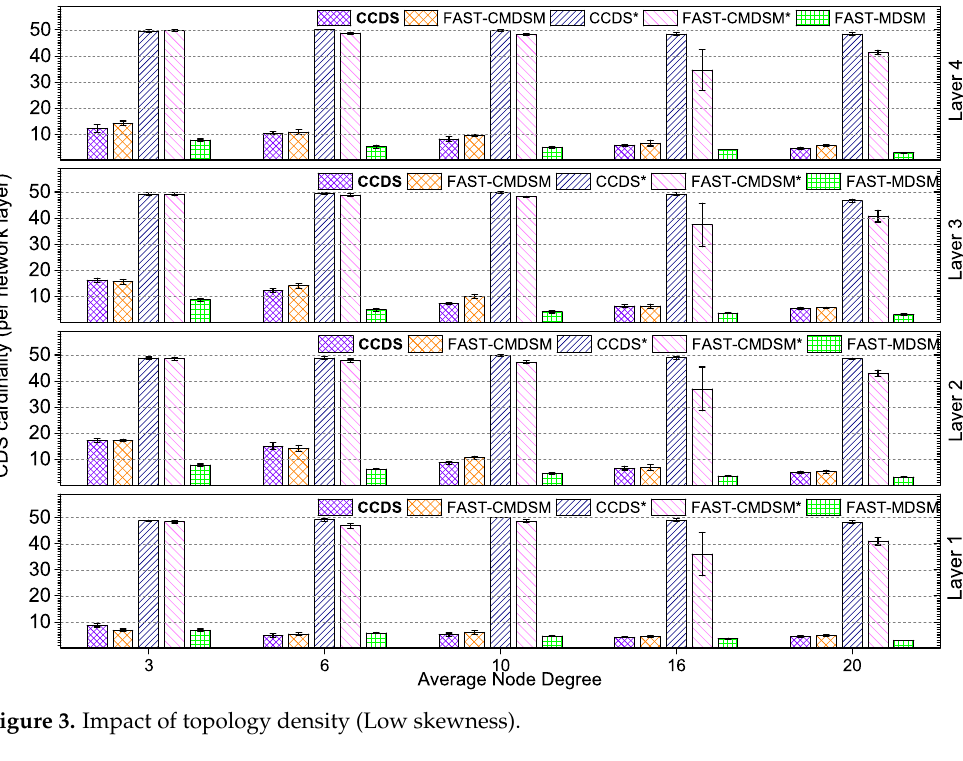
Figure 3. Impact of topology density (Low skewness).